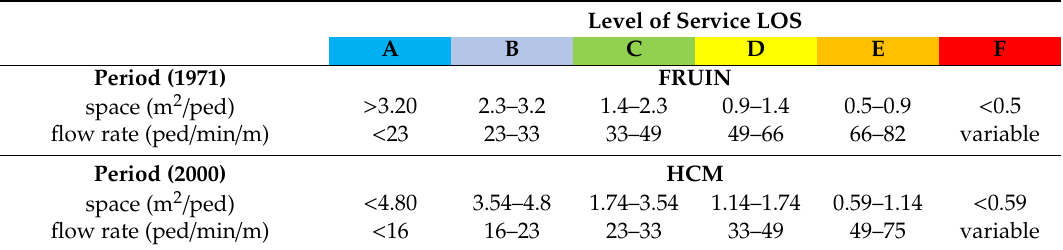
Table 2. Level of Service value